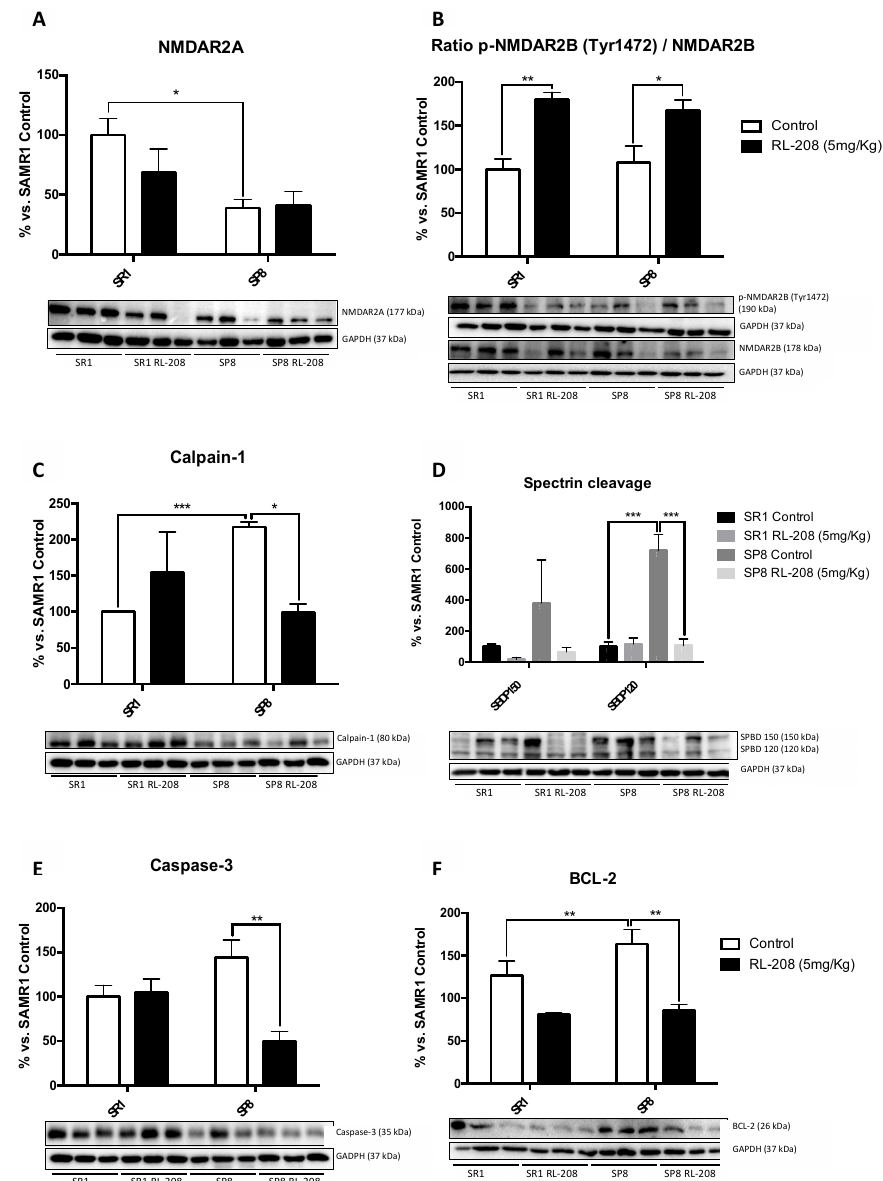
Figure 3. Representative Western Blot and quantifications for NMDAR2A ( A ), the ratio of p-NMDA2B / NMDAR2B ( B ), Calpain-1 ( C ), ratio SBPD / Spectrin ( D ), Caspase-3 ( E ), BCL-2 ( F ). Values in bar graphs are adjusted to 100% for protein levels of the control SAMR1 (SR1 Ct). Values are the mean ± Standard error of the mean (SEM); (n = 6 for each group). * p < 0.05; ** p < 0.01; *** p < 0.001. 3.4. Increased Neurotrophins and Synaptic Markers Protein Levels after Treatment with RL-208